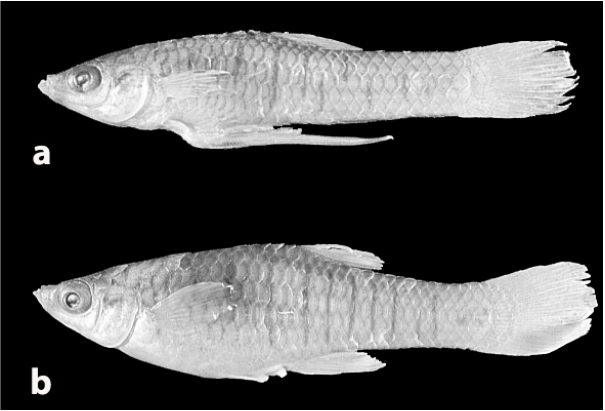
Fig. 5. Phalloptychus iheringii , MCP 11054, Tubarão, rio Tubarão and lateral channels near Campo Verde, Santa Catarina, Brazil. ( a) male, 18.3 mm SL; (b) female, 25.7 mm